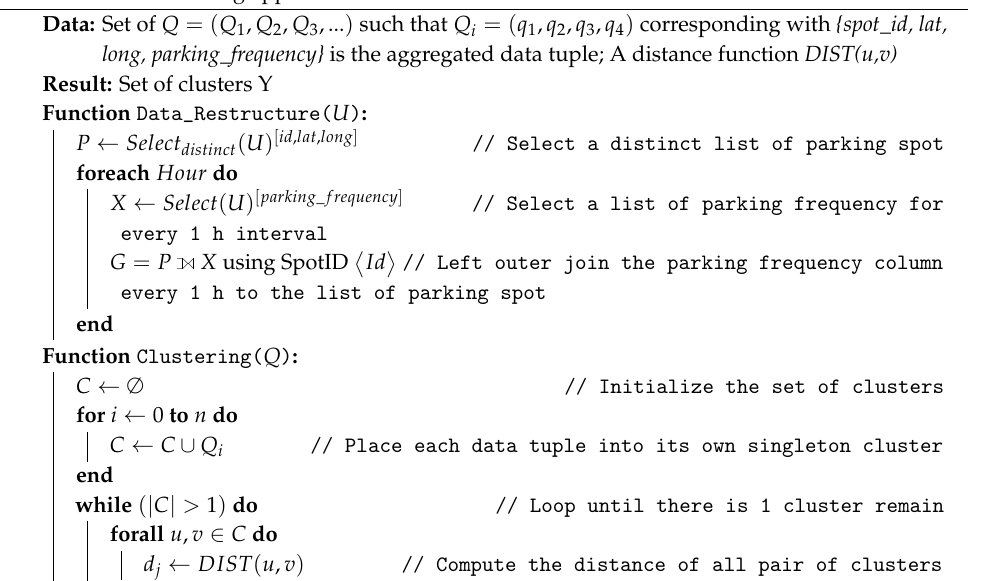
Algorithm 1: Data clustering implementation for aggregated data based on Agglomerate Hierarchical Clustering